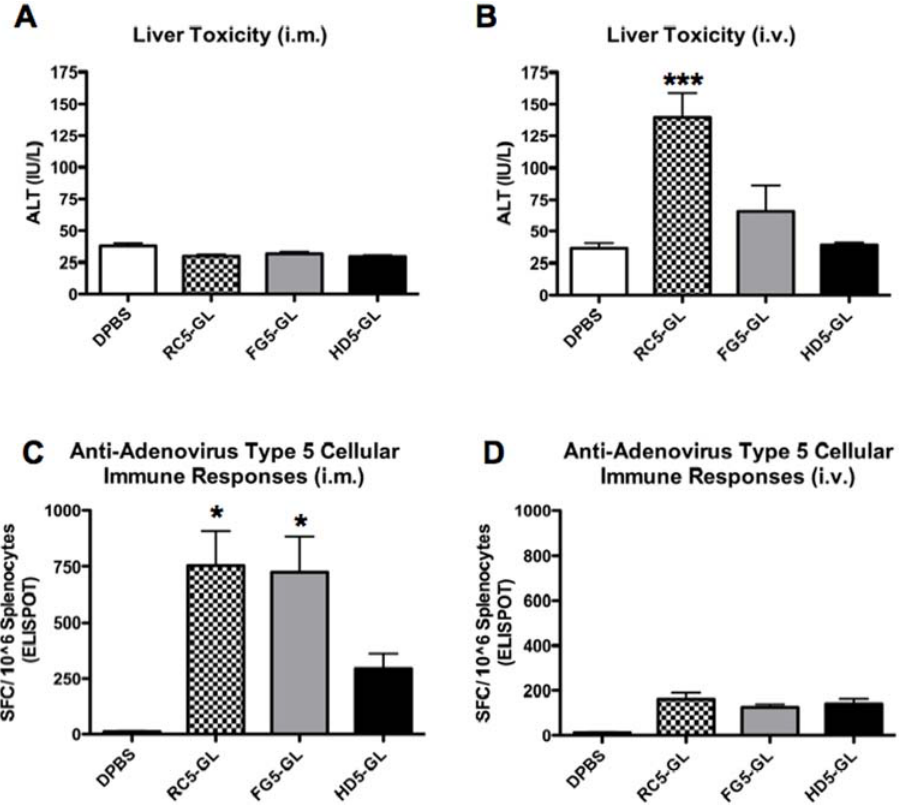
Figure 4. Toxicity and anti-vector cellular immune responses. Toxicity and the induction of anti-vector cellular immune responses were measured. Liver toxicity is expressed as a measured of ALT expression 48 hours after i.m. (A) and i.v. (B) injection. Anti-adenovirus cellular responses were measured 4 wks after i.m. (C) and i.v. (D) injections. Naı¨ve BALB/c splenocytes infected with wild-type Ad5 were used as antigen presenting cells and were co-cultured with splenocyted from immunized mice. Anti-Ad5 cellular responses were measured by ELISPOT. Data represent groups of 5 mice and error bars indicate standard error. The data were analyzed by one-way ANOVA (*=p , 0.05 and ***=p , 0.001).